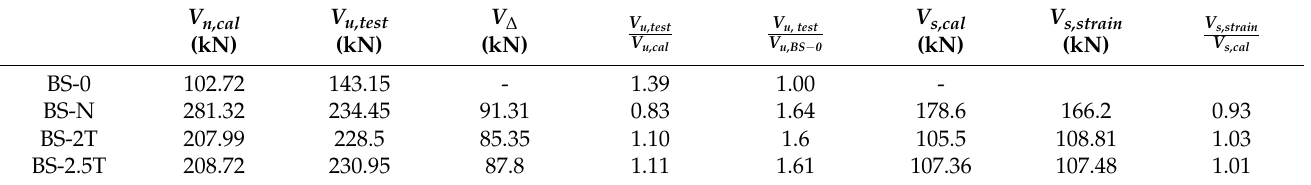
Table 5. Comparison of shear